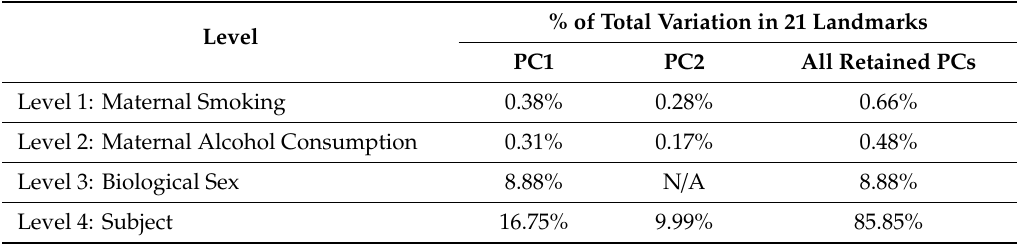
Table 2. Percentage of the total variation in the 21 facial landmarks as explained by each